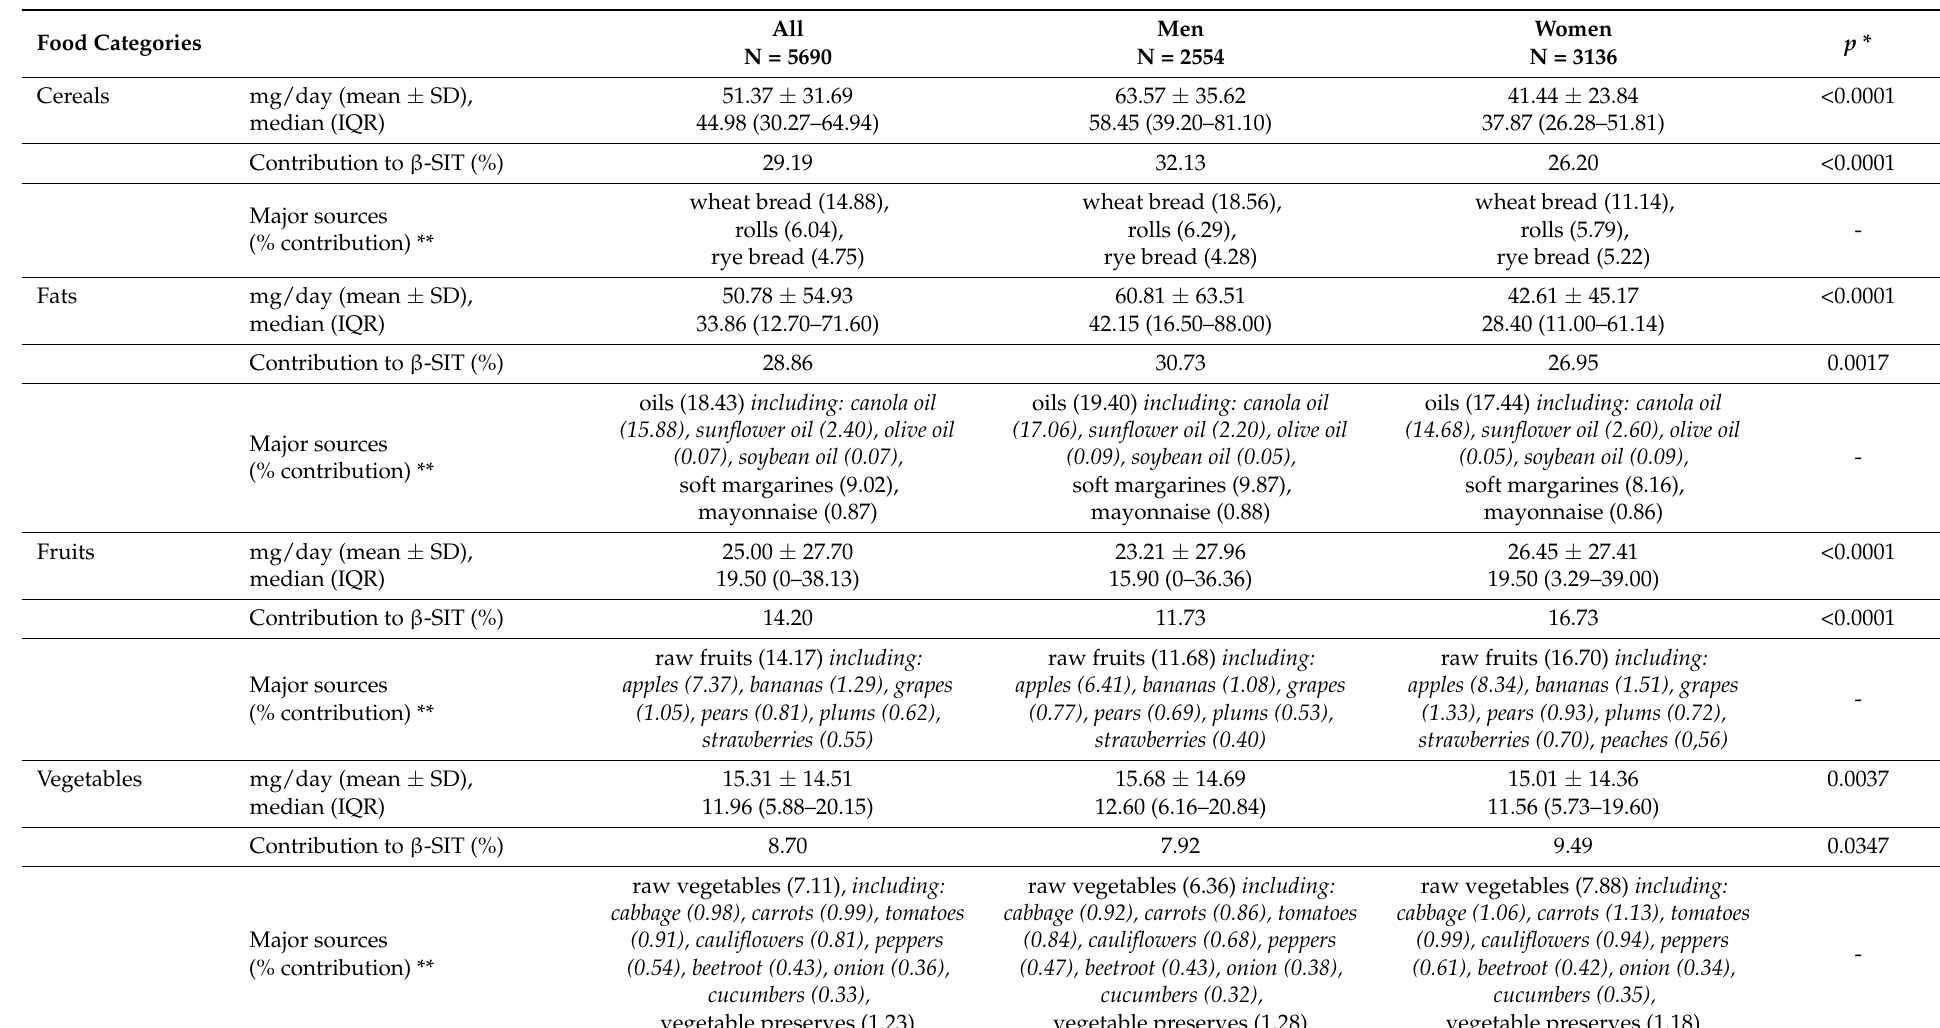
Table 3. Contributions of food categories and individual food products to β -sitosterol intake ( β -SIT), listed according to diminishing order of contribution. Food